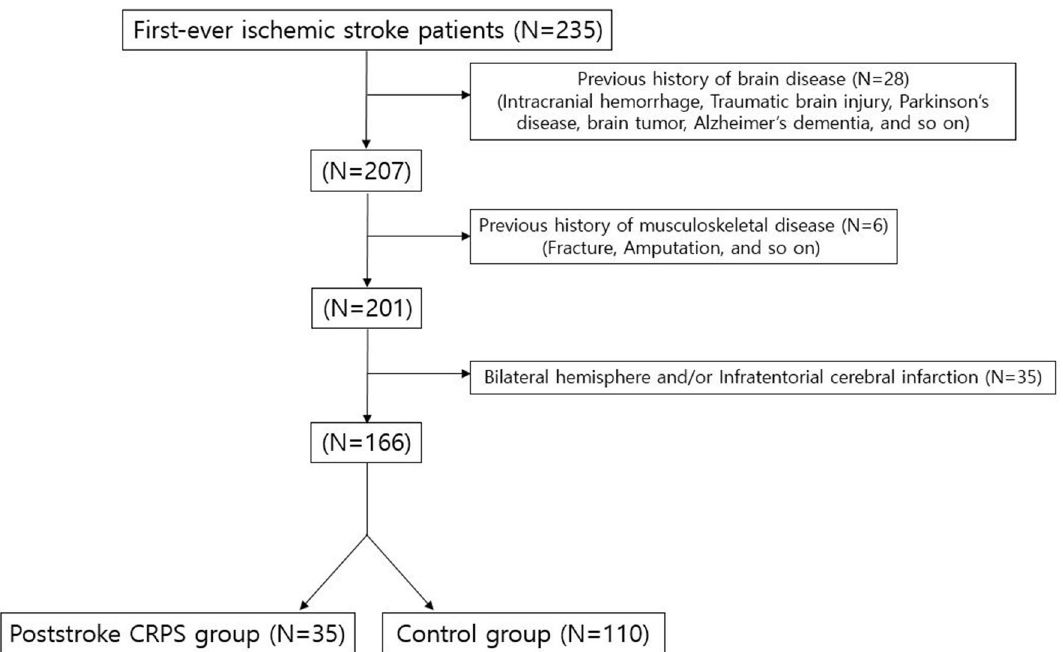
Figure 1. Flow diagram of enrolment of the subjects in the poststroke complex regional pain syndrome (CRPS) and control groups. N means numbers of included subjects. After the classification process, a total of 145 patients were finally included in the study, of which 35 patients and 110 patients were assigned to the poststroke CRPS group and the control group, respectively.